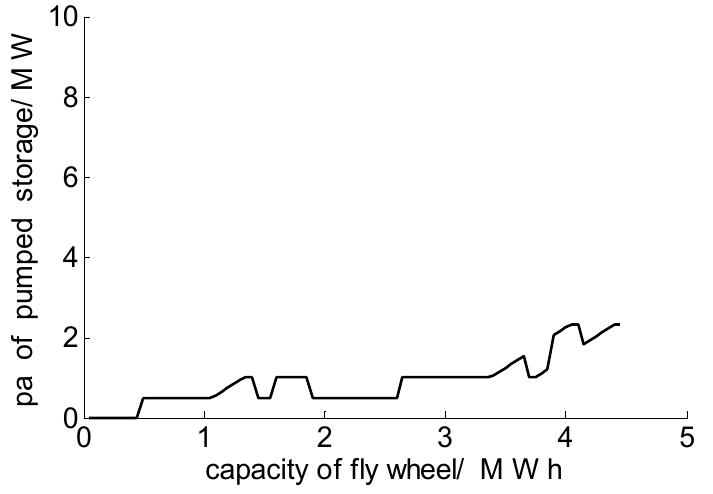
Figure 15. Sensitivity analysis for the capacity of the fly wheel and pa